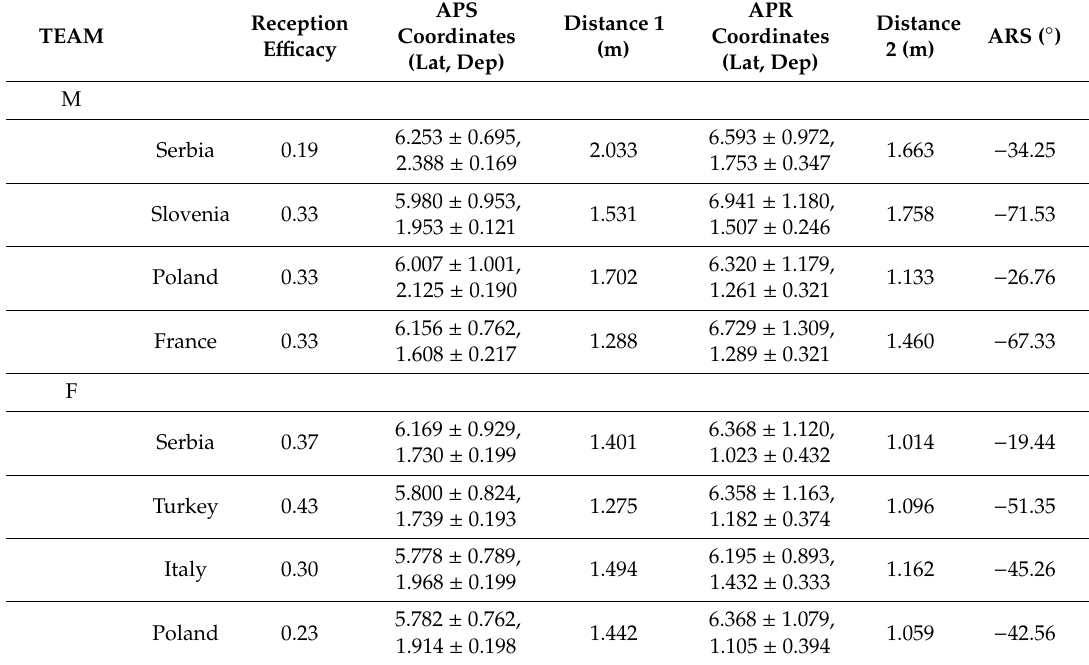
Table 2. Reception e ffi cacy, APS and APR coordinates (latitude and depth; mean ± standard deviation), Distance 1, Distance 2, and ARS of the top four classified teams in each